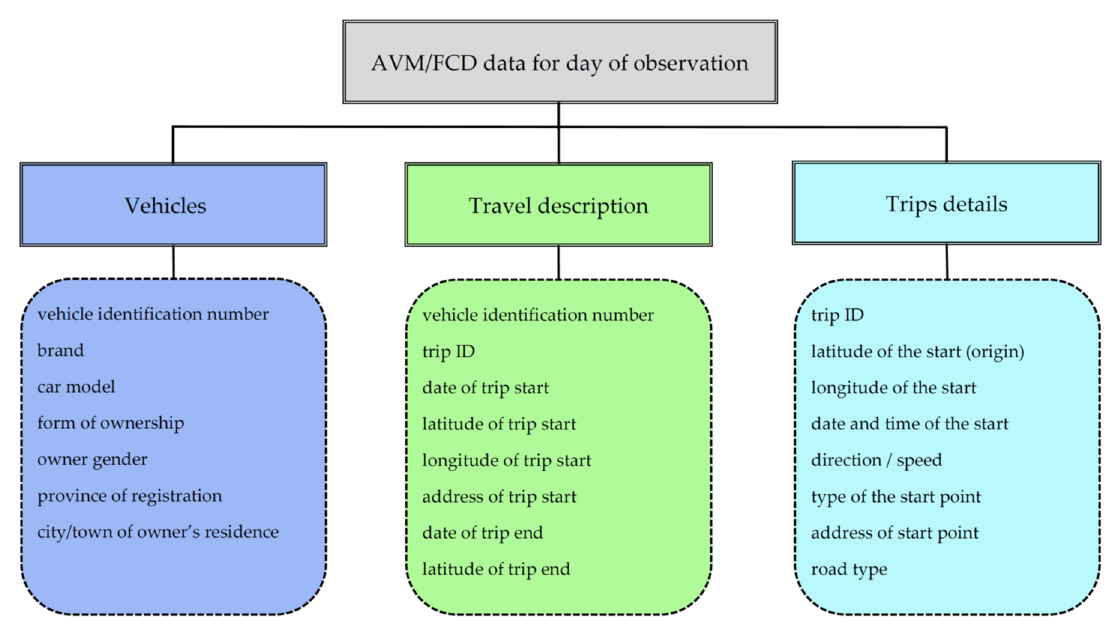
Figure 2. Structure of the AVM/FCD database.